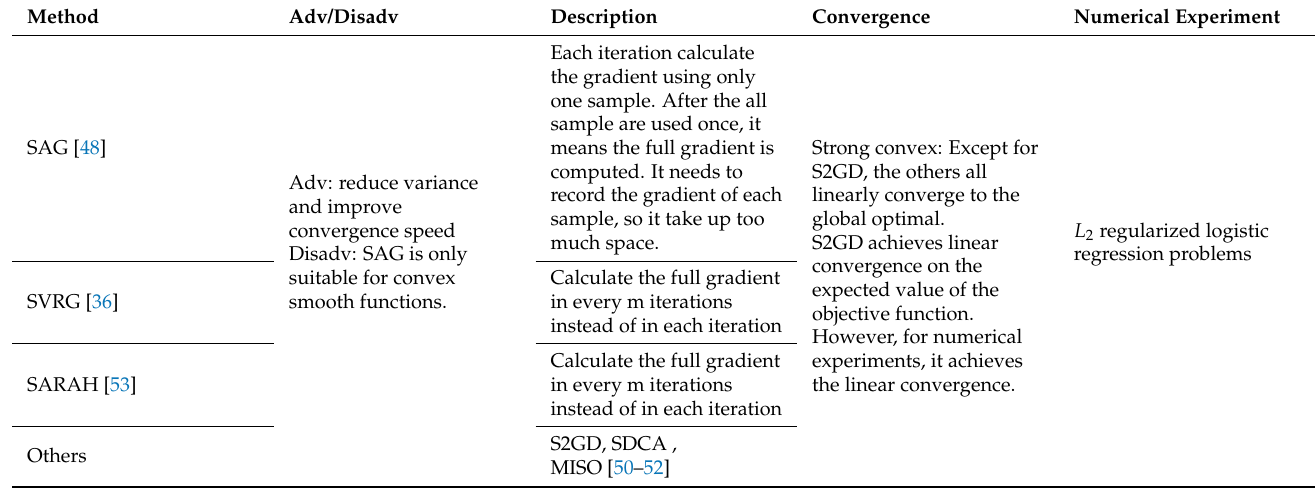
Table 3. Summary of the variance-reducing methods.